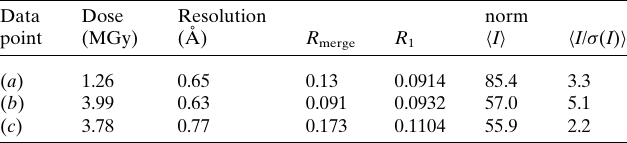
Table 3 Dose and quality parameters for the three selected data points [see Fig. 6 for the definitions of ( a ), ( b ) and ( c )].